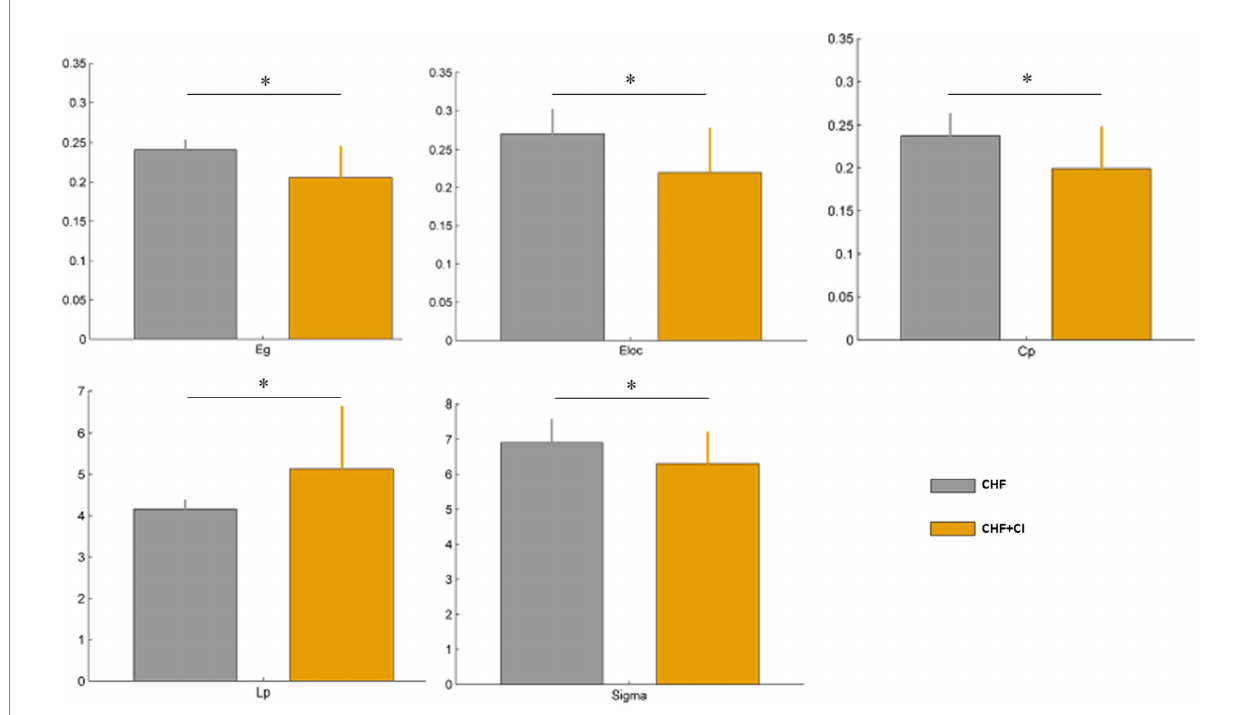
FIGURE 1 The differences in the global network measure subcortical structures between two groups. The global efficiency (Eglobal, Eg), the local efficiency (Elocal, Eloc), the clustering coefficient (Cp), the small-world attribute (sigma, σ ) were significantly reduced in the CHF patients complicated with CI (CHF + CI) compared with the controls (CHF). The shortest path length (Lp) was longer in the CHF + CI group than in the CHF group (* p < 0.05, FEW corrected).